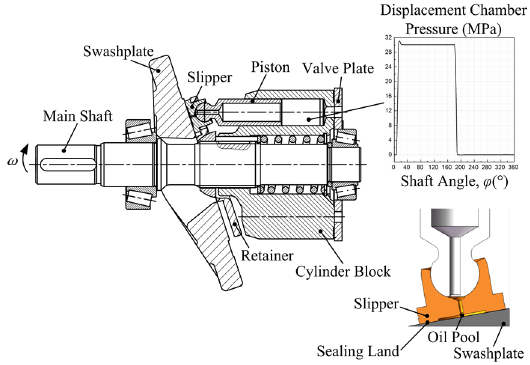
Figure 2. Structural diagram of axial piston pump.